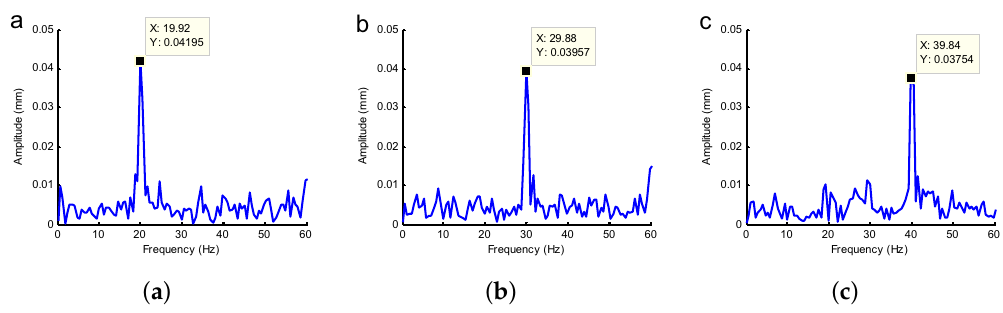
Figure 13. The frequency spectrum of out-plane displacement at different rotation speed: ( a ) 1200 rpm; ( b ) 1800 rpm; and ( c ) 2400 rpm.